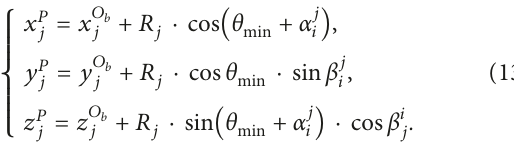
Figure 8: Schematic view of 3D joint in axial